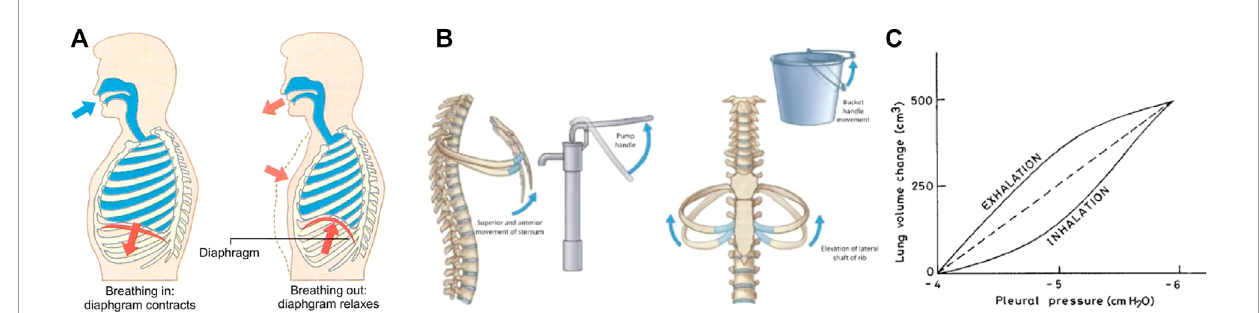
FIGURE 2 Illustration of respiratory function. Upward motion of the diaphragm during exhalation reduces lung volume and chest displacement (A) (Sebel et al., 1985). Displacement is also governed by sternum and rib mechanics (B) (Arthittayapiwat et al., 2019). Volume and corresponding displacement are not completely symmetrical and vary between subjects and depth of breathing (C) (Menon and Agrawal, 2003).